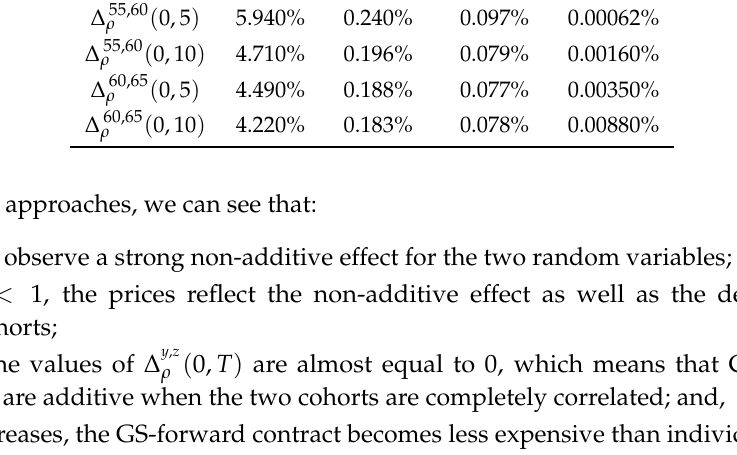
Table 11. ∆ y , z ρ ( 0, T ) values for different ages and maturities, Sharpe approach. ρ = 0 ρ = 0.95 ρ = 0.98 ρ = 1 ∆ 55,60